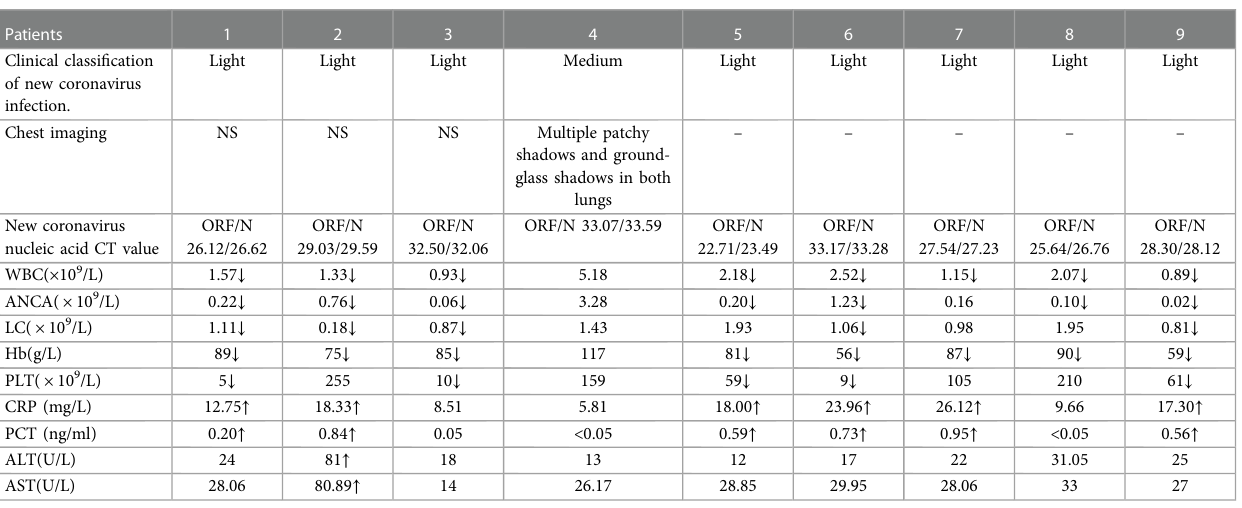
TABLE 2 Laboratory test results of 9 children with hematological diseases in group A infected with novel coronavirus. Patients Clinical classi fi cation of new coronavirus infection.